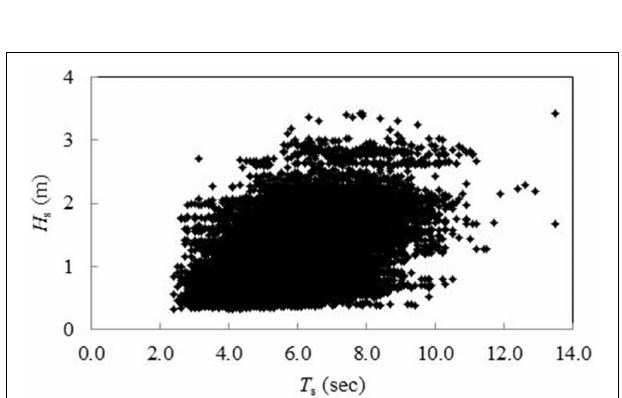
FIGURE 3 | Significant wave height and wave period measured between 2001 and